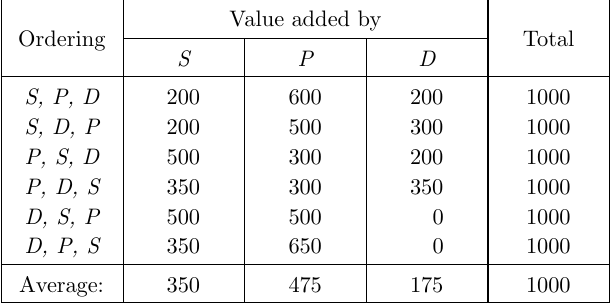
The calculation of the Shapley Value for the jazz band game (1)